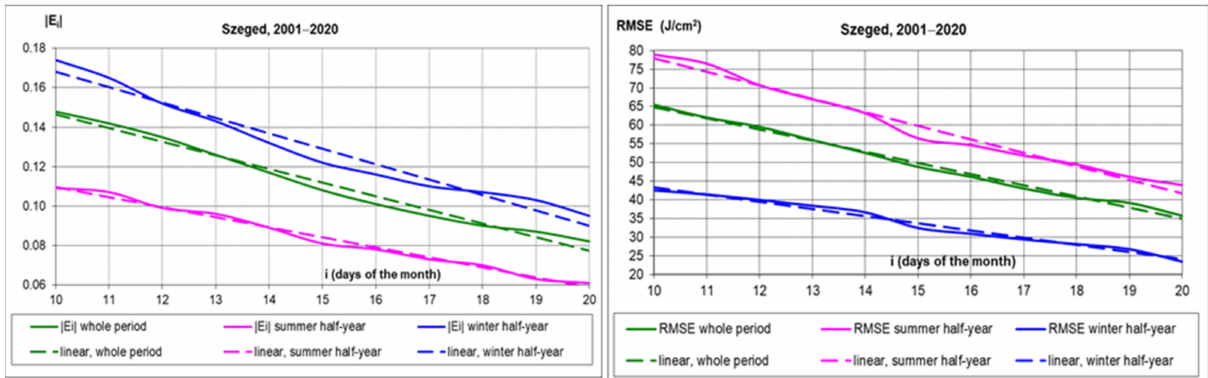
Figure 10. Mean absolute deviations (| E i |) and RMSE values and the corresponding trend lines in the middle third of the